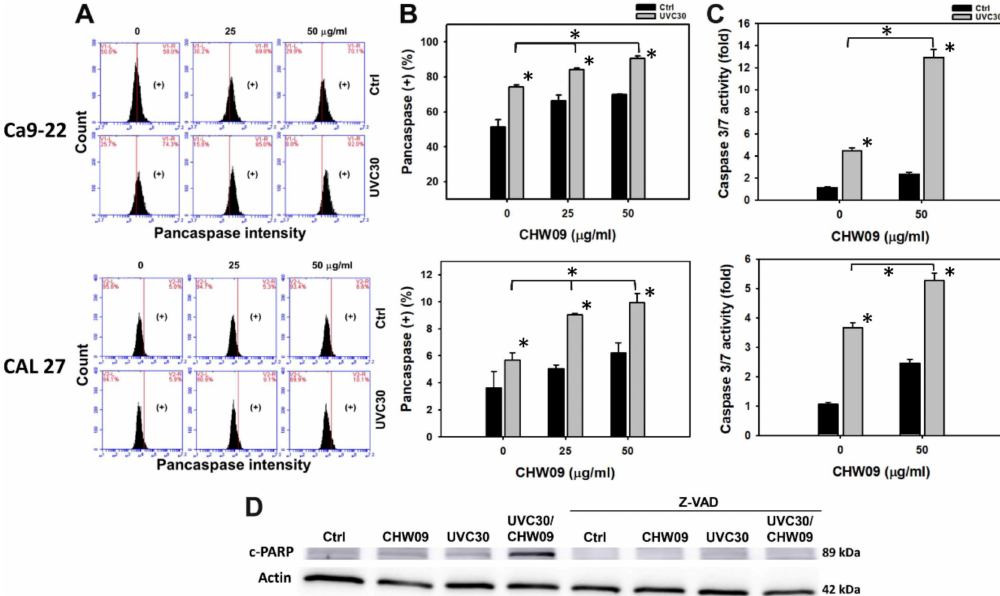
Figure 4. Changes of apoptosis (caspase activity) of UVC and / or CHW09 treatments in oral cancer cells. Cells (Ca9-22 and CAL 27) were pretreated with UVC irradiation UVC (0 and 30 J / m 2 ) and / or post-treated with CHW09 (control, 25, and 50 µ g / mL) for 24 h. ( A ) Representative pattern of pancaspase analysis for UVC and / or CHW09 treatment. ( + ) in the right side of each panel indicates the pancaspase ( + ) (%). ( B ) Statistics in Figure 4A. Data, mean ± SD ( n = 3 independent experiments). For multiple comparison, significance of the di ff erence was examined by one-way ANOVA and the Tukey HSD Post Hoc Test. *, p < 0.0001. * without line indicates the significance between control and UVC30. * with line indicates the significance between UVC30 / CHW09 and others. ( C ) Cas 3 / 7 activity in CHW09 and / or UVC-treated Ca9-22 and CAL 27 cells. Cas 3 / 7 activity was determined by ELISA assays. ( D ) Expressions of cleaved form to PARP (c-PARP) in CHW09 and / or UVC-treated Ca9-22 cells in the absence and presence of Z-VAD pretreatment (100 µ M for 2 h).